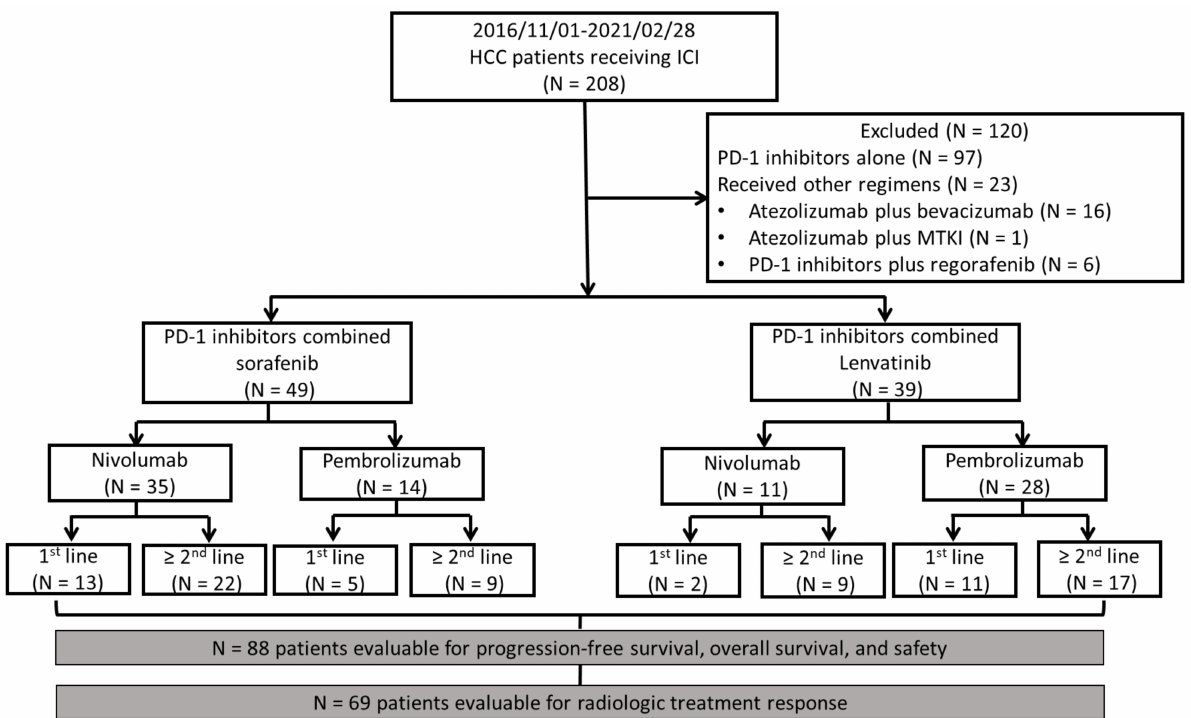
Figure 1. Flowchart for patient inclusion demonstrating the inclusion criteria, exclusion criteria, and number of patients in all the groups. Of the 19 patients not available for response assessment, 18 patients died before the radiologic evaluation and 1 patient was lost to follow-up. ICI, immune checkpoint inhibitor; MTKI, multitarget tyrosine kinase inhibitor; PD-1 inhibitor, programmed cell death protein-1